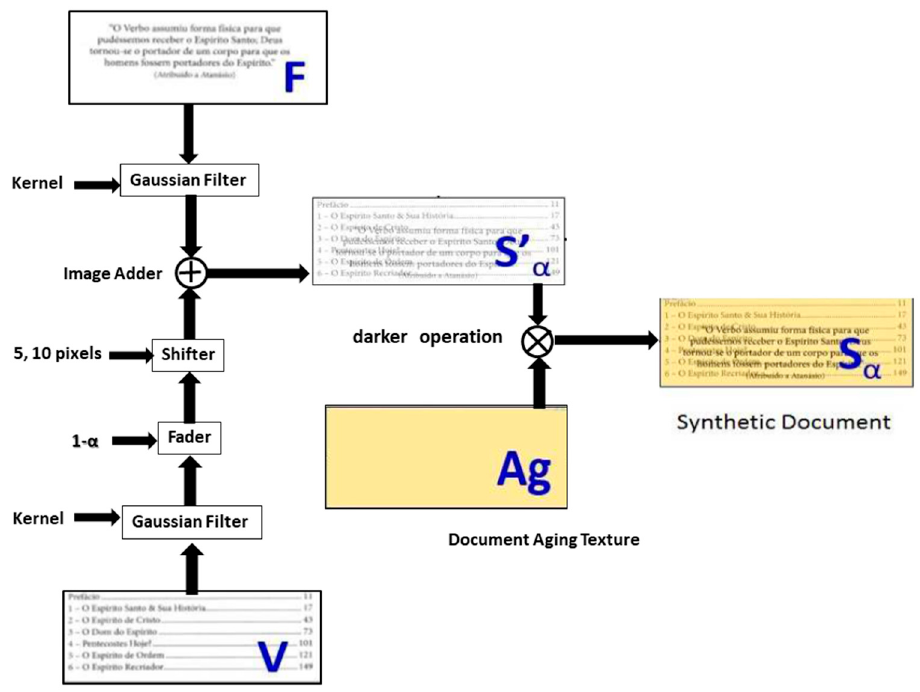
Figure 4. Block diagram of the scheme for the generation of synthetic images for the Decision-Making Block.